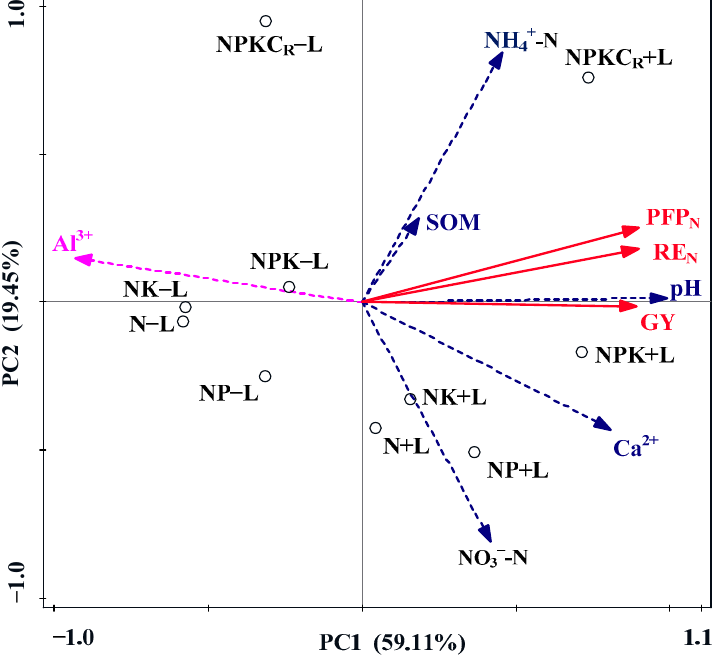
Figure 5. CANOCO redundancy analysis scores and loading biplot showing clustering of fertilizers under − L and +L and soil properties (pH, NO 3 − -N, NH 4+ -N, SOM, Al 3+ , and Ca 2+ ) as explanatory variables to explain the variation in the response variables crop N recovery efficiency (RE N ), N partial factor productivity (PFP N ) and grain yield (GY). The angle between the arrows in the biplot represents the correlation between the corresponding variables with 0 and 180 ◦ indicating the maximum positive and negative correlation and 90 ◦ indicating no correlation. Soil properties variables are indicated with dashed arrows and NUE and GY variables with solid arrows. N: Nitrogen, NP: N and phosphorus (P), NK: N and potassium (K), NPK: N, P, and K, NPKC R : NPK plus crop residue (C R ), − L: without lime application, +L: with lime